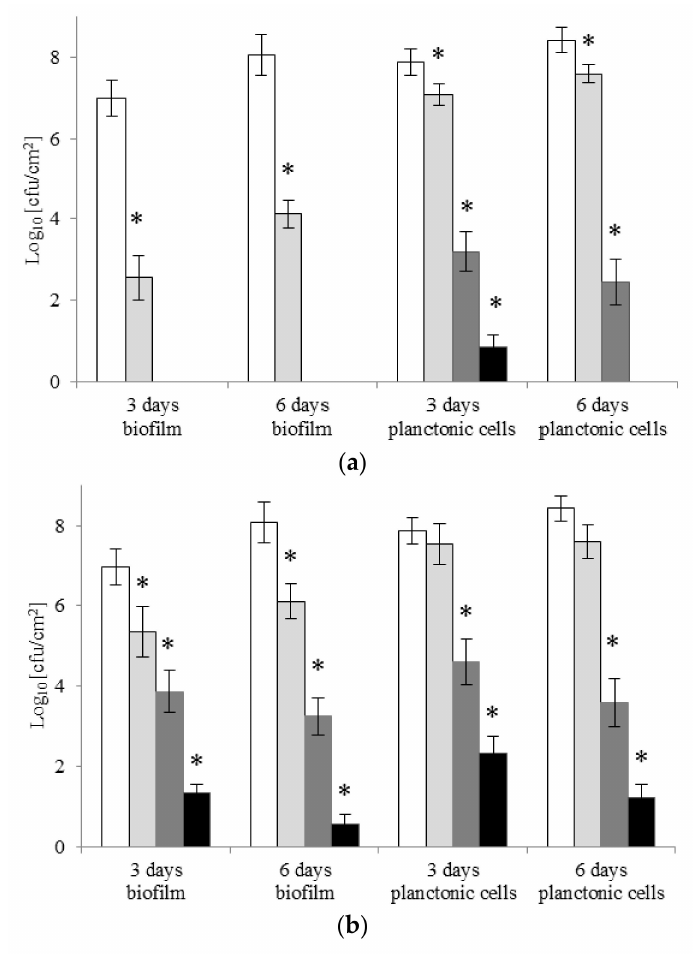
Figure 3. Effect of gemini C6 ( a ) and monomeric DTAB ( b ) surfactants on biofilm formation by A. lannensis FMW1. The results are presented for samples with surfactants in the concentration 1 / 4 MIC (clear grey bar), 1 / 2 MIC (dark grey bar), MIC (black bar), and compared to the control sample without surfactants (white bar). * Reduced value of log 10 differed significantly from the control without